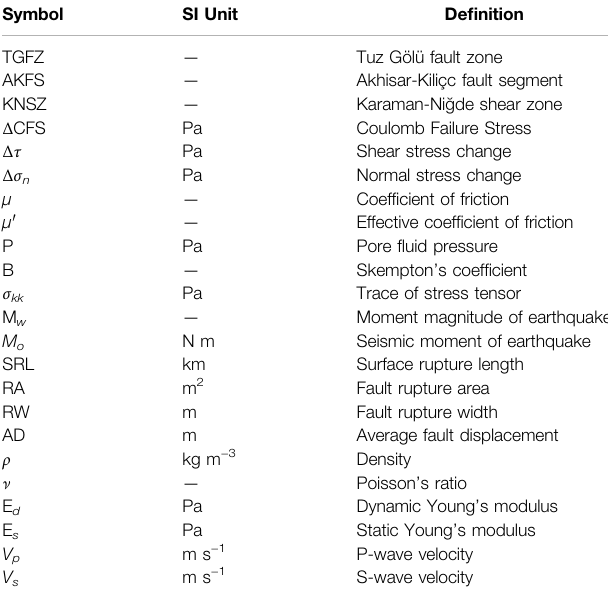
TABLE 2 | Abbreviations, units and de fi nitions. Symbol SI